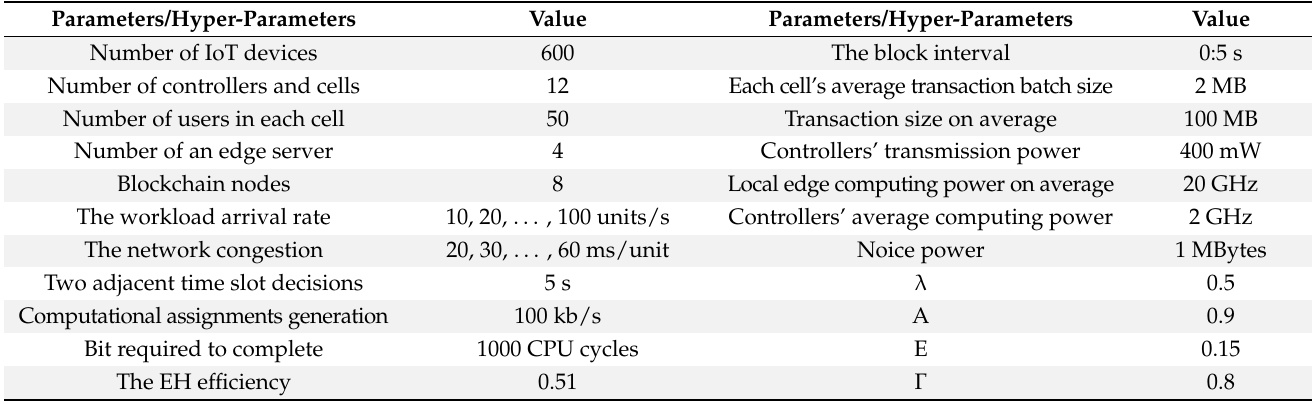
Table 3. Parameters